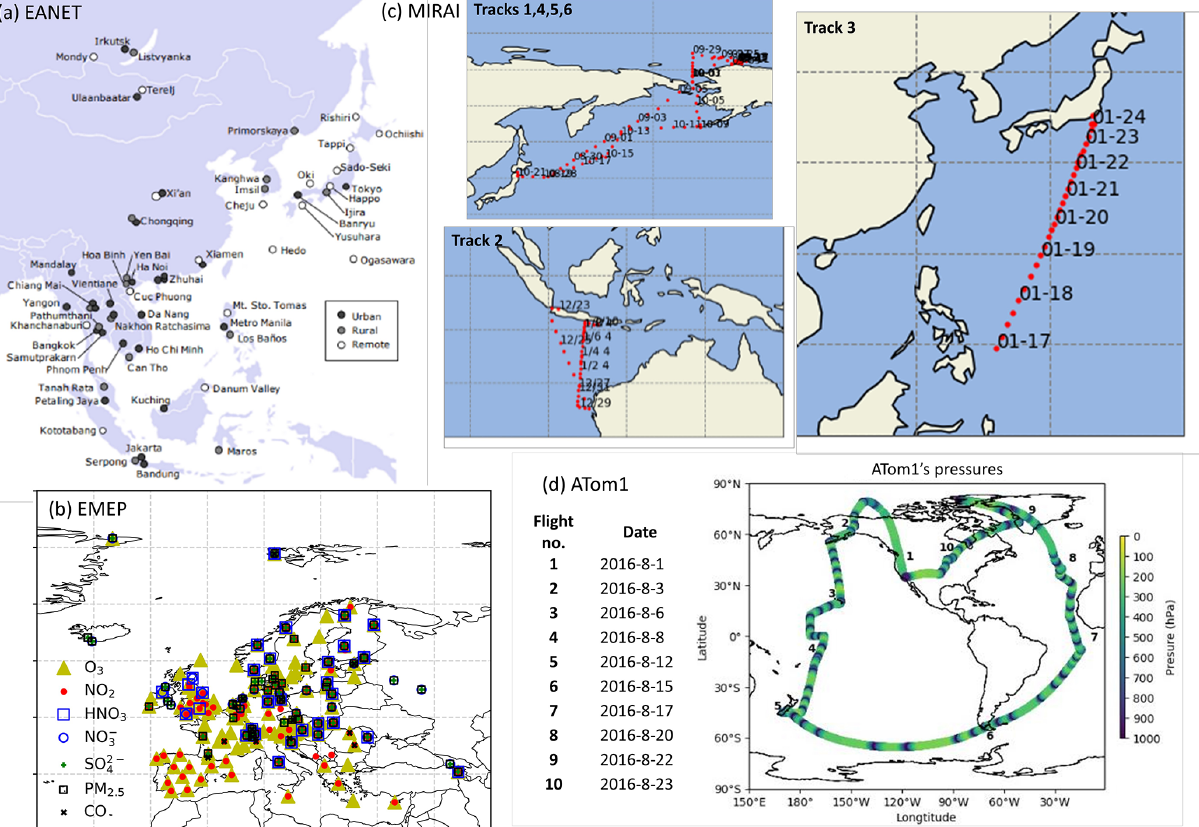
Figure 1. Locations of EANET stations (a) , EMEP stations (b) , Mirai cruises (c) , and ATom1 flights (d) . The source for panel (a) is https://monitoring.eanet.asia/document/overview.pdf (last access: 12 June 2020). Table 4. Datasets used for verification in this study. Verified species Regions Data Time series Time step Sulfate, nitrate, NO x , O 3 , HNO 3 Eastern Asia EANET Daily to 2-weekly Sulfate, nitrate, NO x , O 3 , CO Europe CO, O